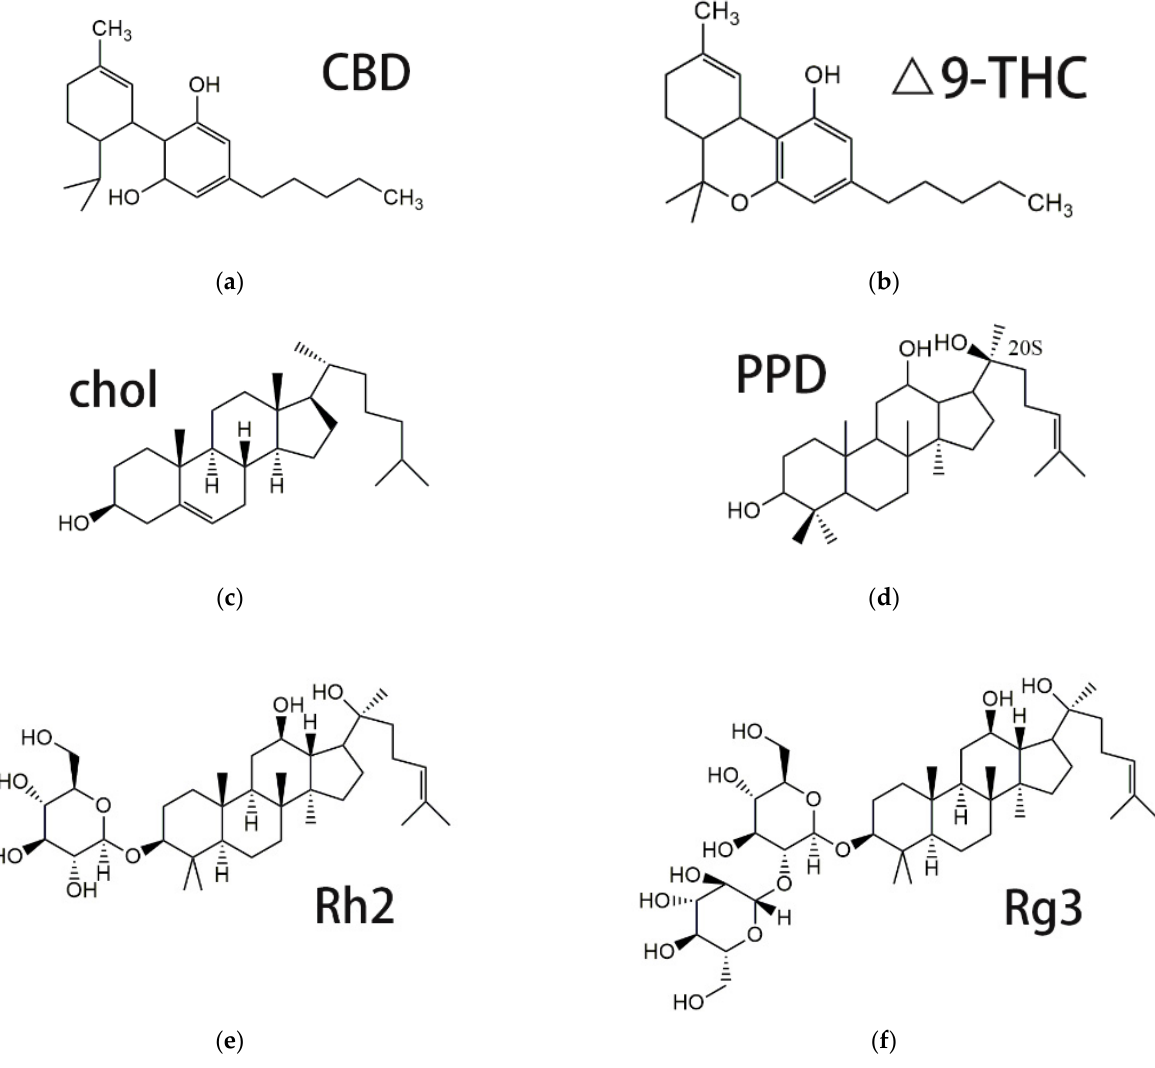
Figure 1. Chemical structure of CBD ( a ), Δ 9 -THC ( b ), Chol ( c ), PPD ( d ) and ginsenoside Rh2 ( e ) and Rg3 ( f ).